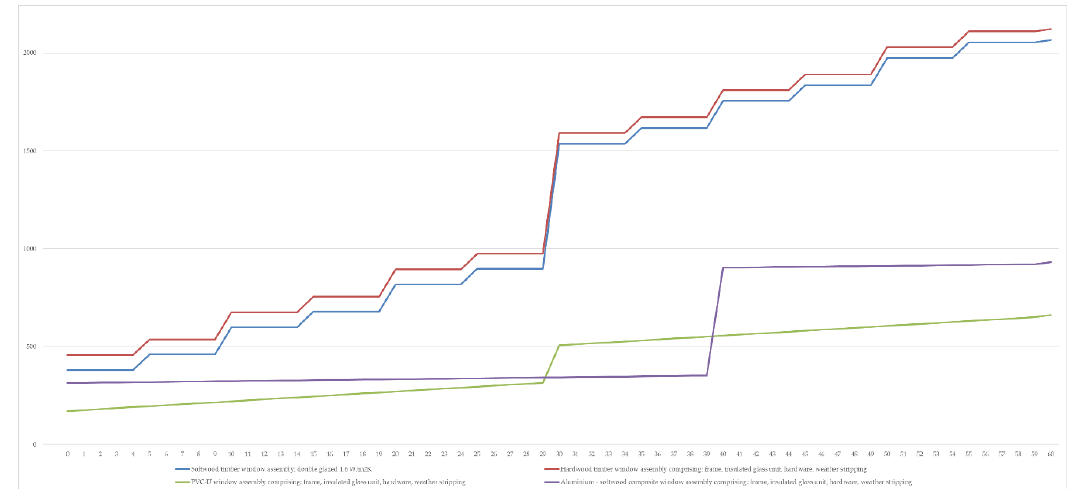
Figure 8. Component comparison of four window types (cumulative undiscounted cost estimation).